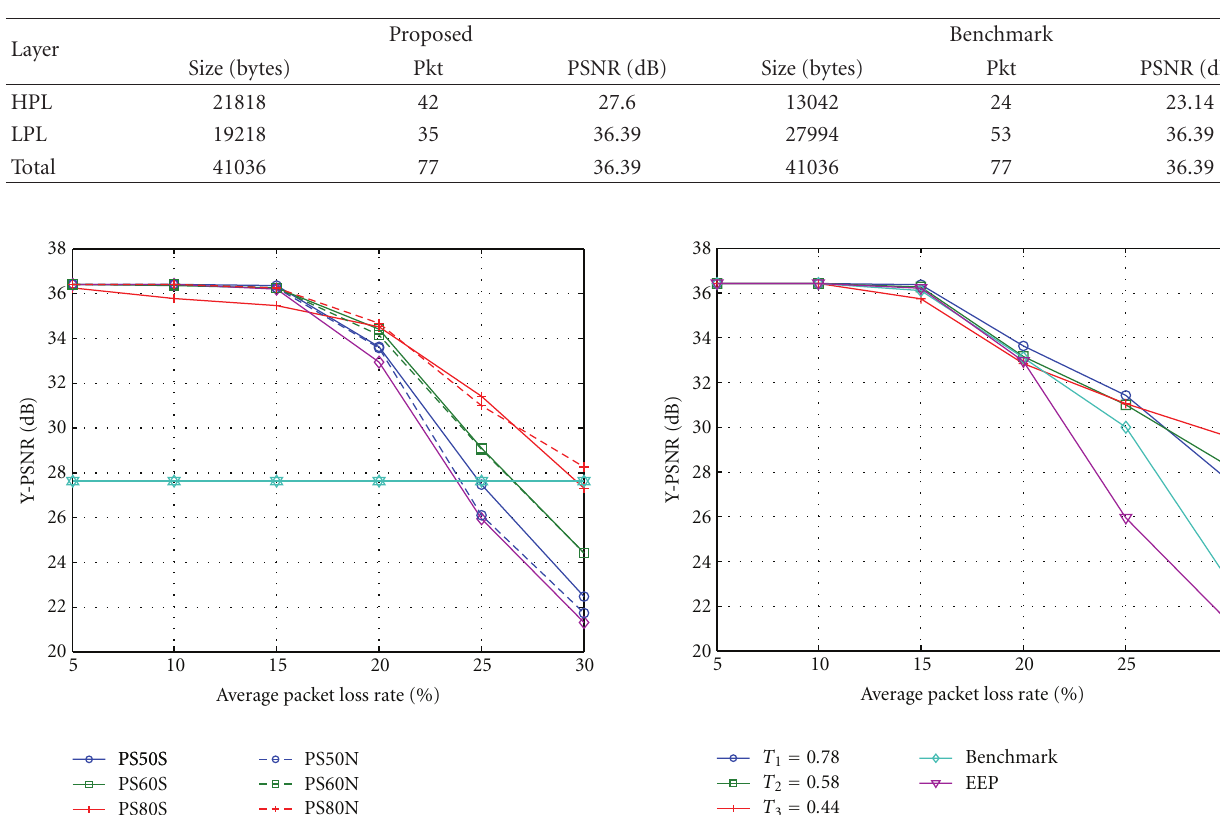
Table 1: Layer sizes and PSNR contributions for T = 0 . 78 and w = 2 . 5 for Foreman sequence.